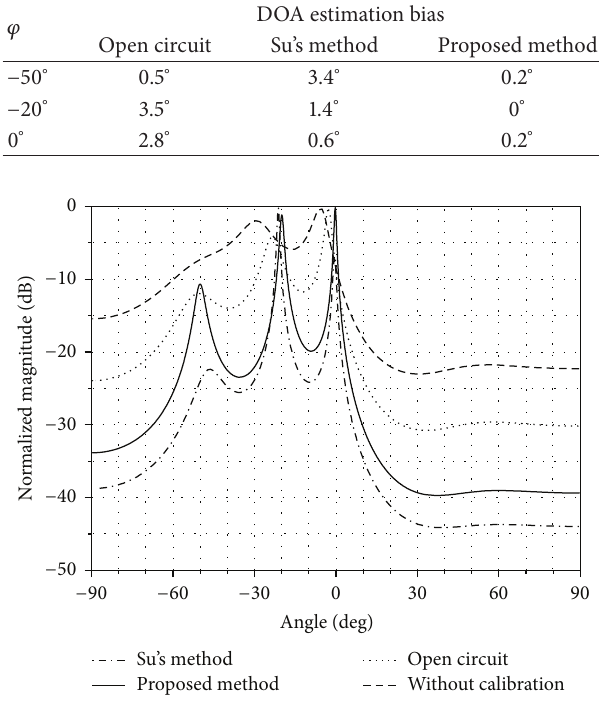
Figure 3: Spatial spectrum of DOA estimations for three incident signals employing the linearly polarized microstrip